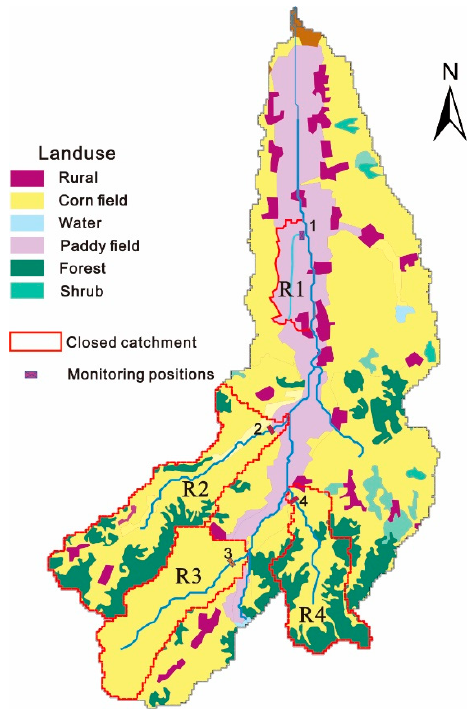
Figure 2. Land use types, streams, and observation sites in the catchments.